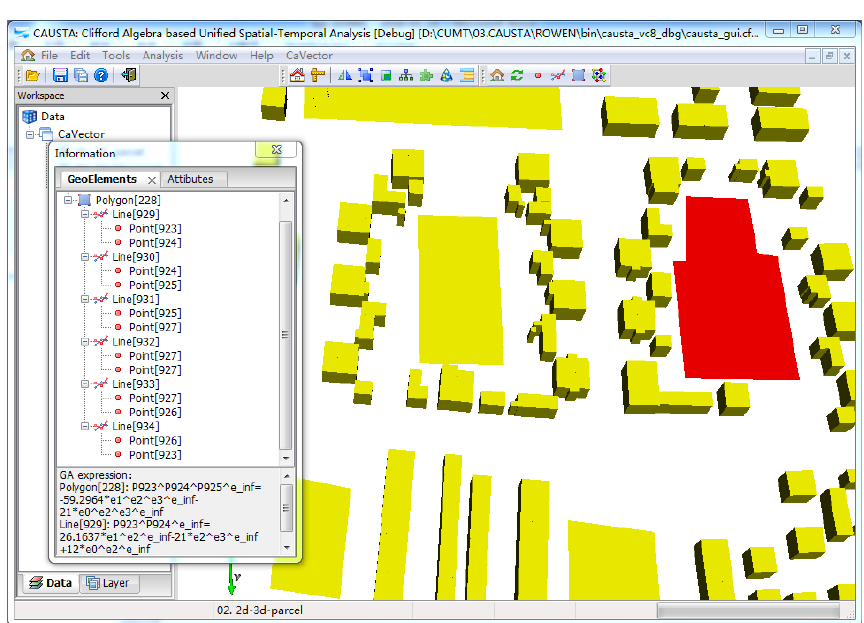
Figure 8. Uniform representation form for different dimensional objects in CGA.